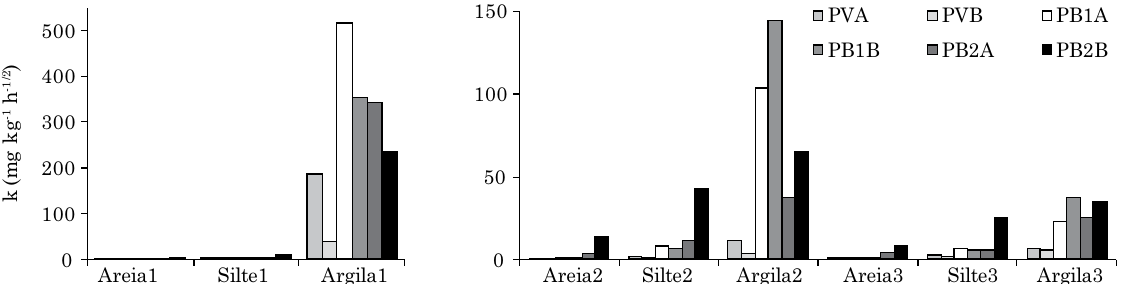
Figura 3. Coeficientes angulares (k) da cinética de liberação de K + na primeira (a), segunda e terceira (b) fases nas frações areia, silte e argila dos argissolo analisados. pva: horizonte a do pvd; pvb: horizonte bt do pvd. pb1a: horizonte a do pbac1; pb1b: horizonte bt do pbac1; pb2a: